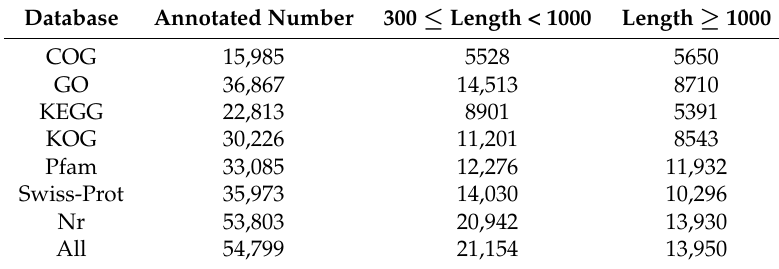
Table 2. Annotation of the unigenes against different databases. COG, Clusters of Orthologous Groups; GO, Gene Ontology; KEGG, Kyoto Encyclopedia of Genes and Genomes; KOG, EuKaryotic Orthologous Groups; Pfam, Protein Families; Nr, Non-Redundant